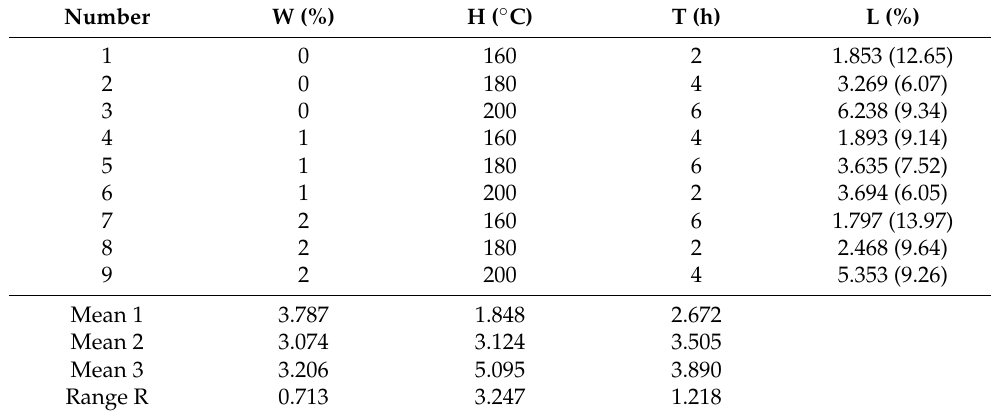
Table 2. Visual Analysis of weight loss rate of impregnated heat-treated wood.